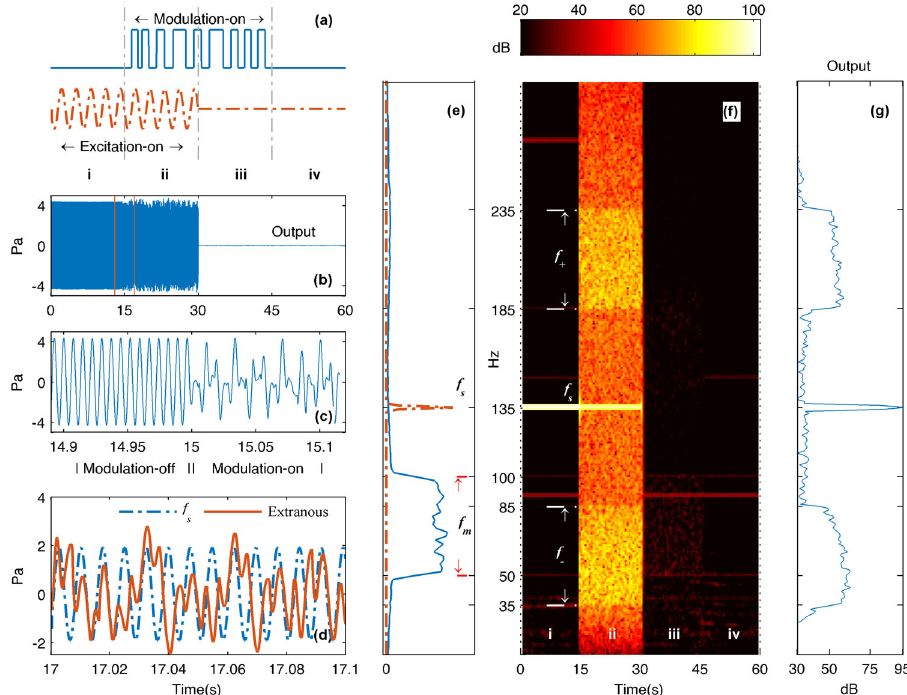
Fig. 5 Experimental results for the conversion of monochromatic sound to band-limited white noise by a randomized acoustic meta-layer. a Illustration of the incident sound introduced from time 0 – 30 s (signal period not to scale in illustration) and the random modulation introduced from 15 – 45 s, forming four time-segments labeled as (i – iv). b Transmitted time-domain pressure signal. c Zoom-in view of the transition from tonal sound (modulation-off) to band-limited white noise (modulation-on) around the 15th second. d Transmitted signal decomposed into the source frequency f s and randomized output from the 17th second. e Spectra of the generated driving signal (dot-dash, f s ) and the modulation voltage (solid line, f m ). f Spectrogram of the transmitted sound downstream, with frequencies of f s , f − , f + marked. g Spectrum of the transmitted pressure